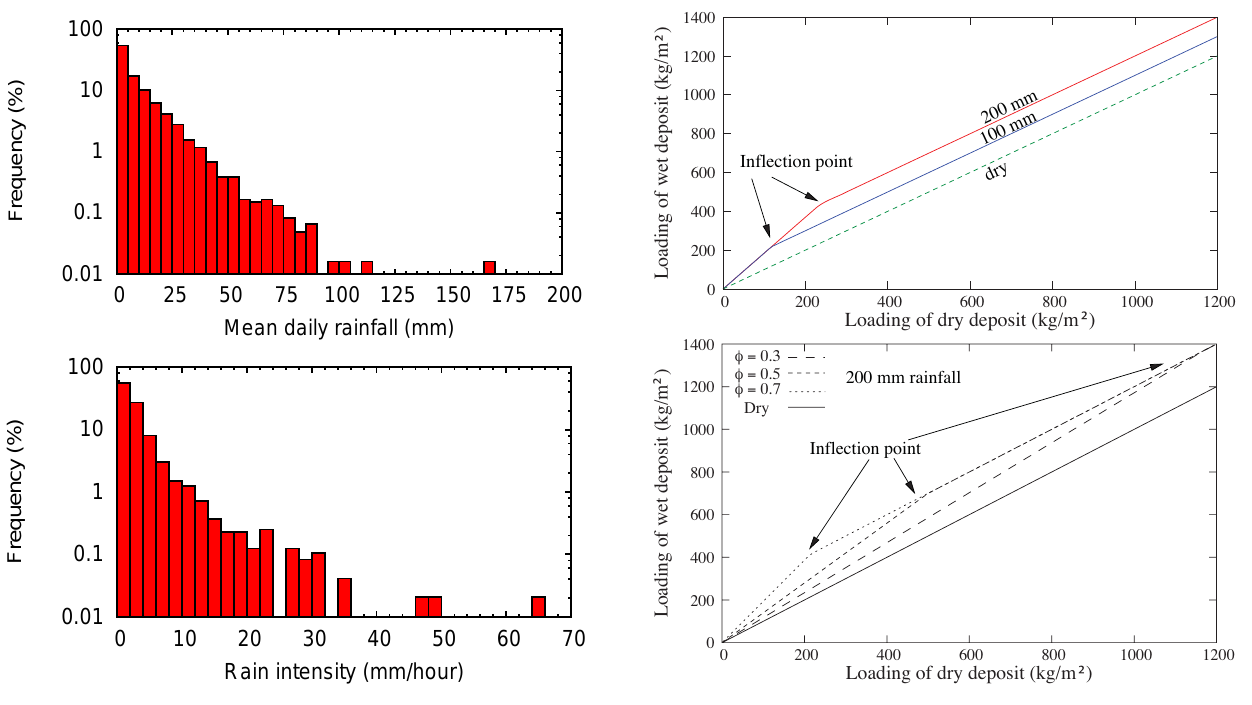
Fig. 1. Top: Frequency of the mean daily rainfall at Vesuvius in the period 1943–2001. Bottom: Frequency of the rain intensity at Vesuvius (same period). Data from Ricciardi et al. (2007).